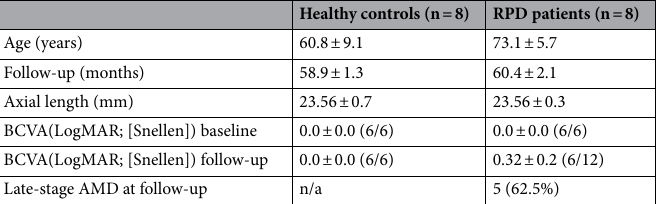
Table 1. Participants’ anthropometric data. Data are means ± SD or n (%). BCVA best corrected visual